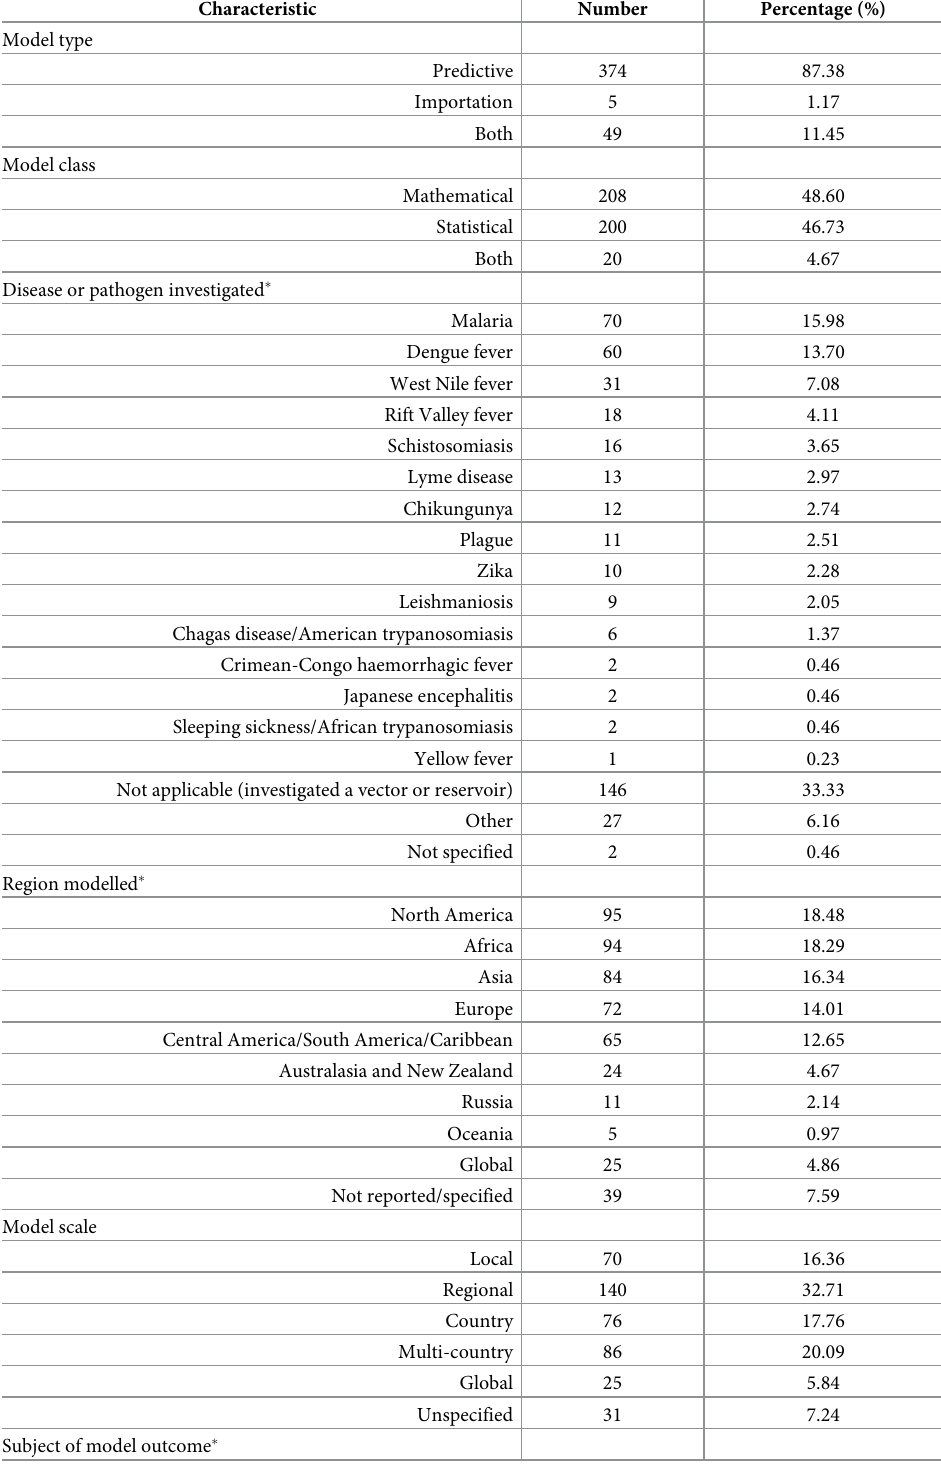
Table 2. Frequency of the characteristics of the models including in the scoping review from 428 relevant